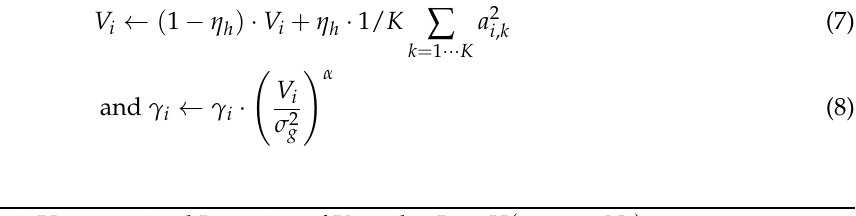
Algorithm 2 Homeostatic Unsupervised Learning of Kernels: Φ = H ( y ; η , η h , N 0 ) 1: Initialize the point nonlinear gain functions z i to similar cumulative distribution